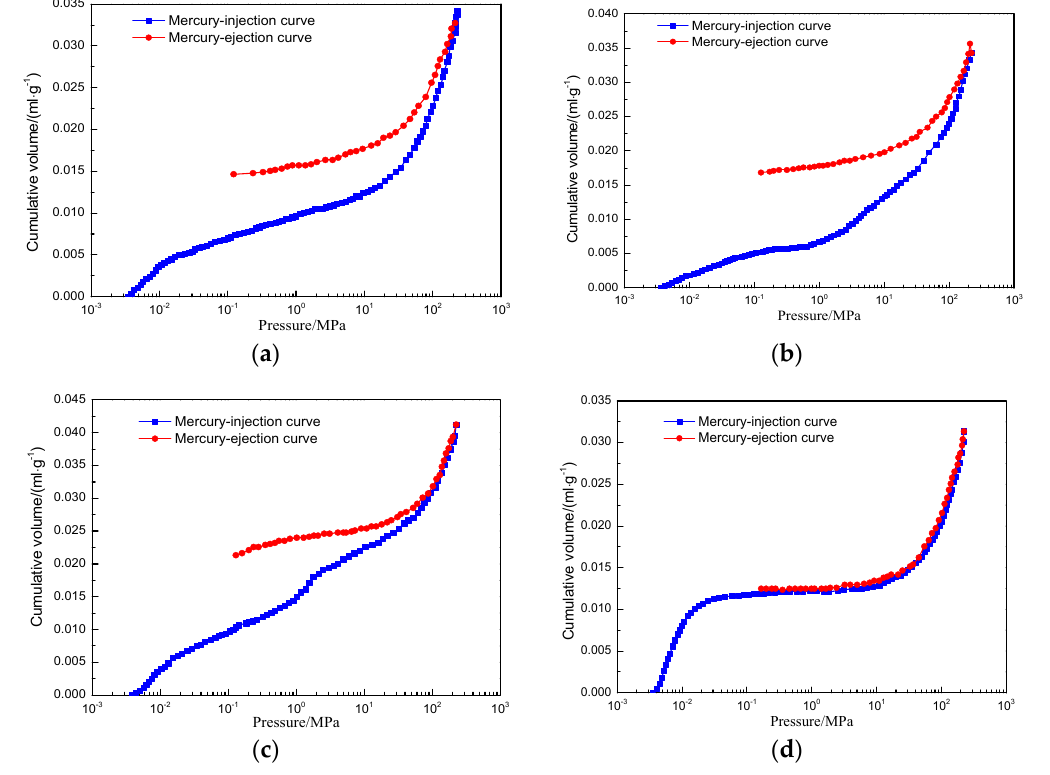
Figure 4. Mercury intrusion curve. ( a ) HY (Heyang); ( b ) SY (Shanyang); ( c ) XZ (Xizhuo); ( d ) DJH (Dongjiahe).